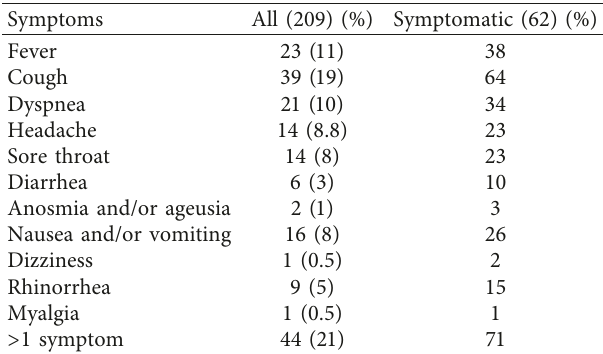
Table 1: Characteristics of COVID-19 symptoms among infected pregnant